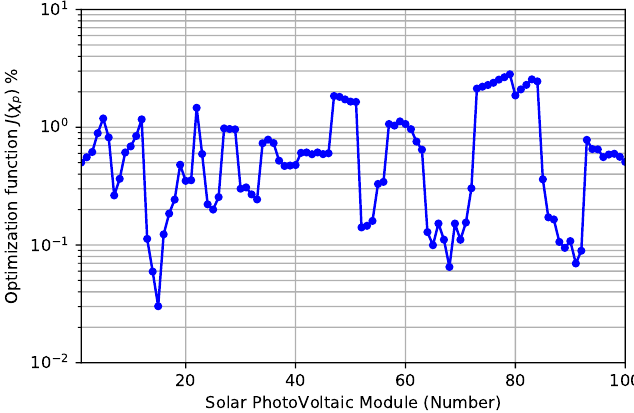
Figure 17. Objective function value J ( χ p ) % for the selected